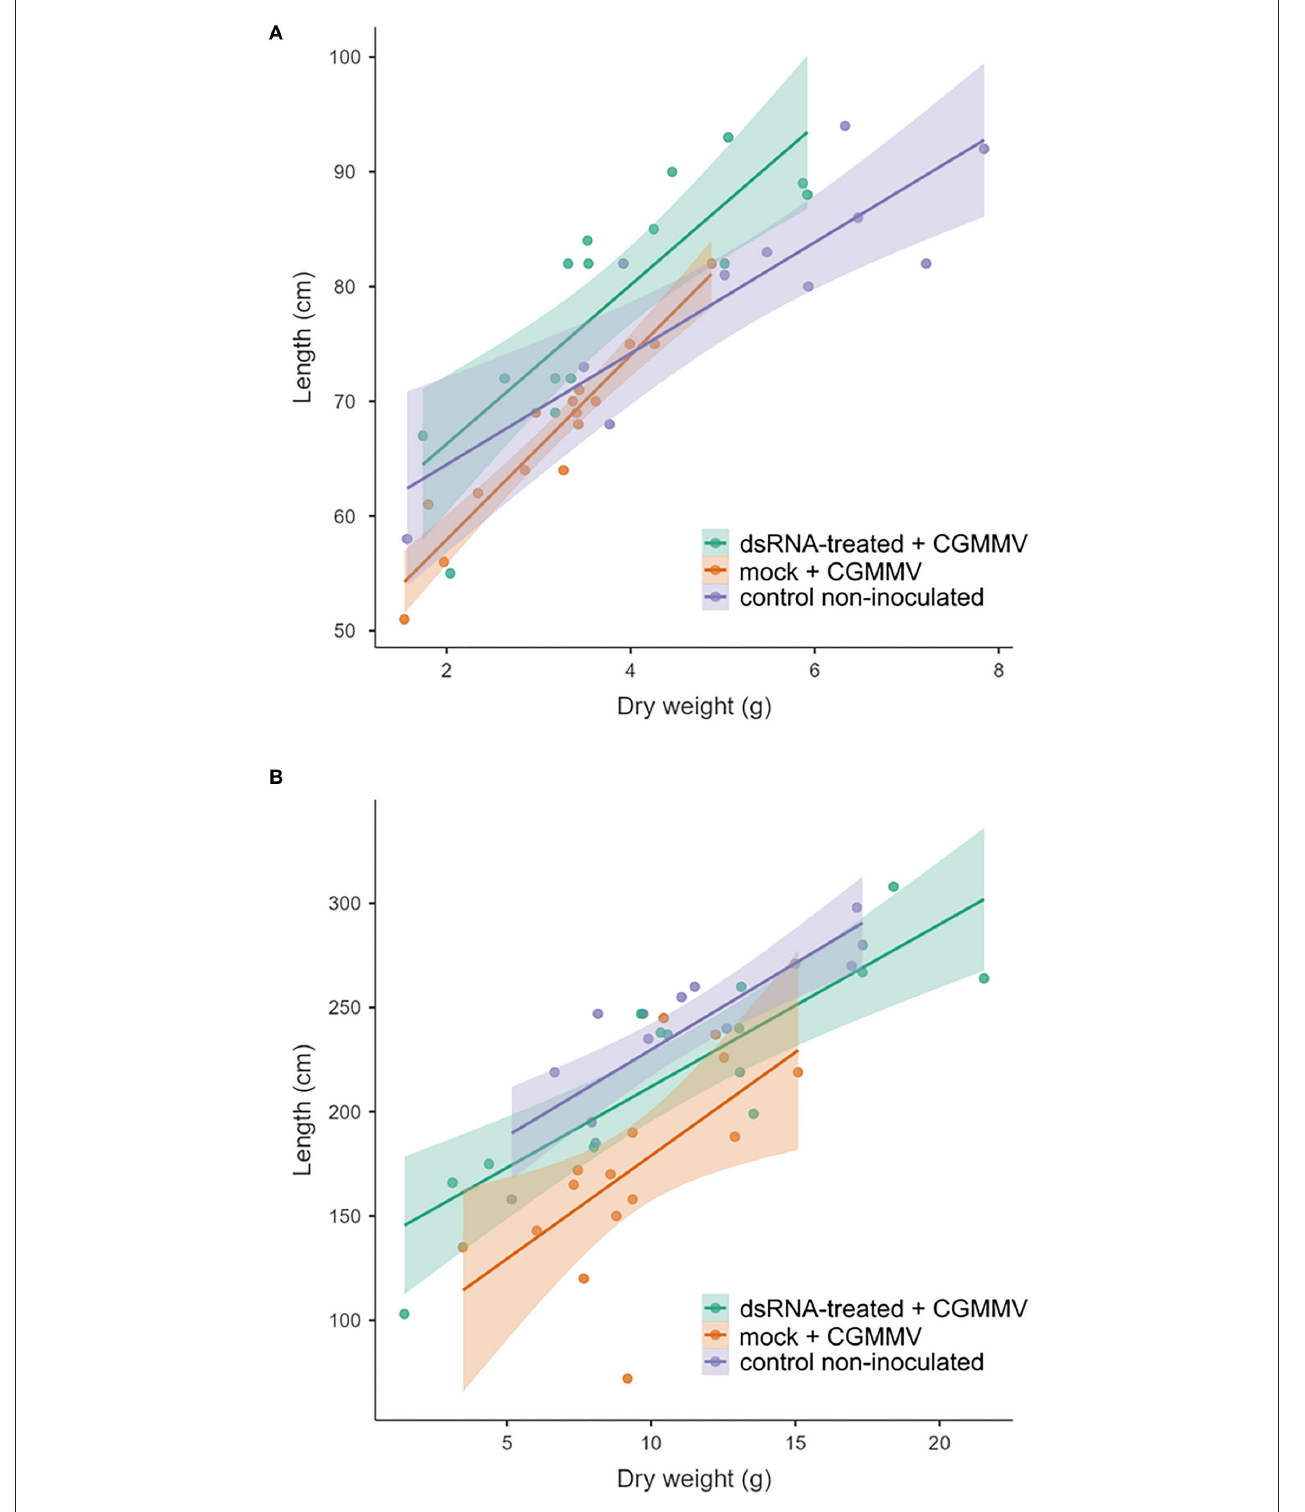
FIGURE 2 | Scatter plot between length and dry weight of the plants of the experiments carried out in (A) spring and (B) summer. For the linear regression analysis, refer to Supplementary Table 3 .